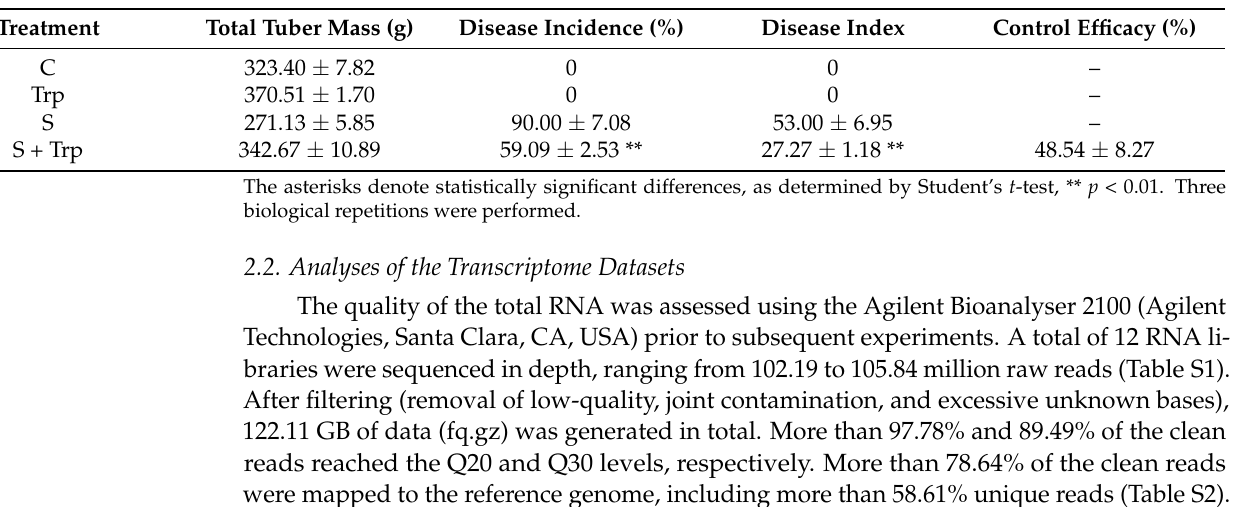
Figure 1. Disease symptoms of potatoes in pots. C: S. scabies -uninoculated plants treated with water; Trp: S. scabies -uninoculated plants treated with Trp; S: S. scabies -inoculated plants treated with water; S + Trp: S. scabies -inoculated plants treated with Trp. Table 1. Disease index and incidence assessment following foliar application of Trp on